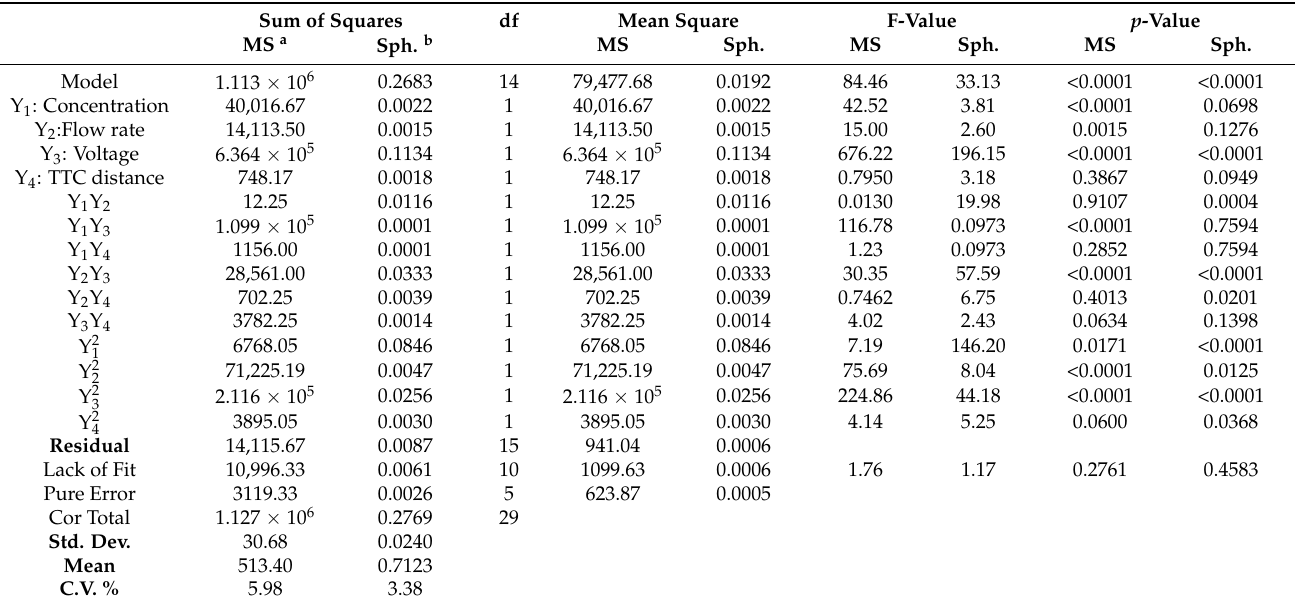
Table 3. Analysis of Variance (ANOVA) Results of Microcapsule size and